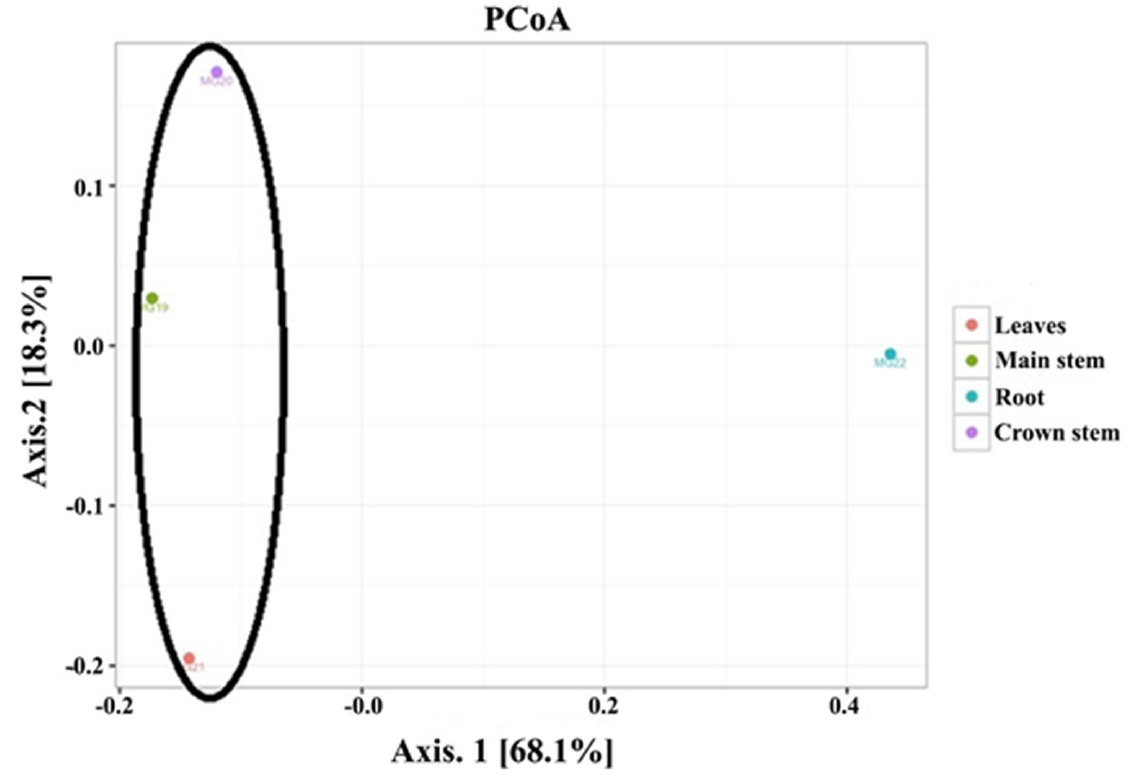
Figure 2. Principal coordinate analysis for the four plant tissues (roots, main stem, crown stem, leaves) of cowpea.